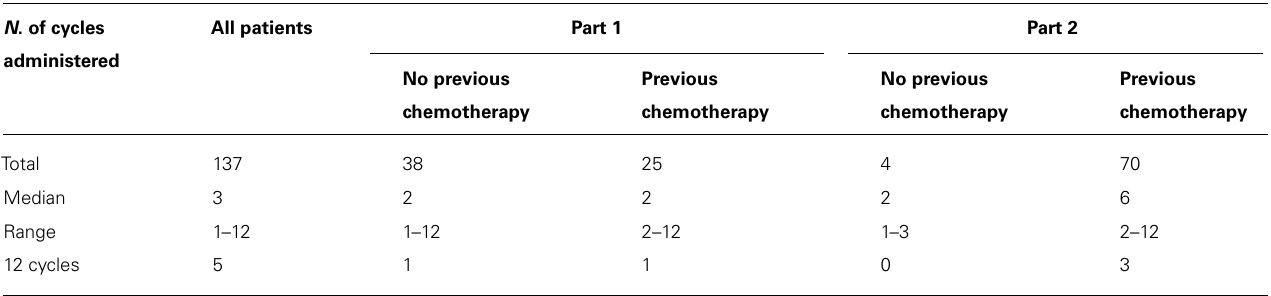
Table 4 |Treatment (cycles administered).